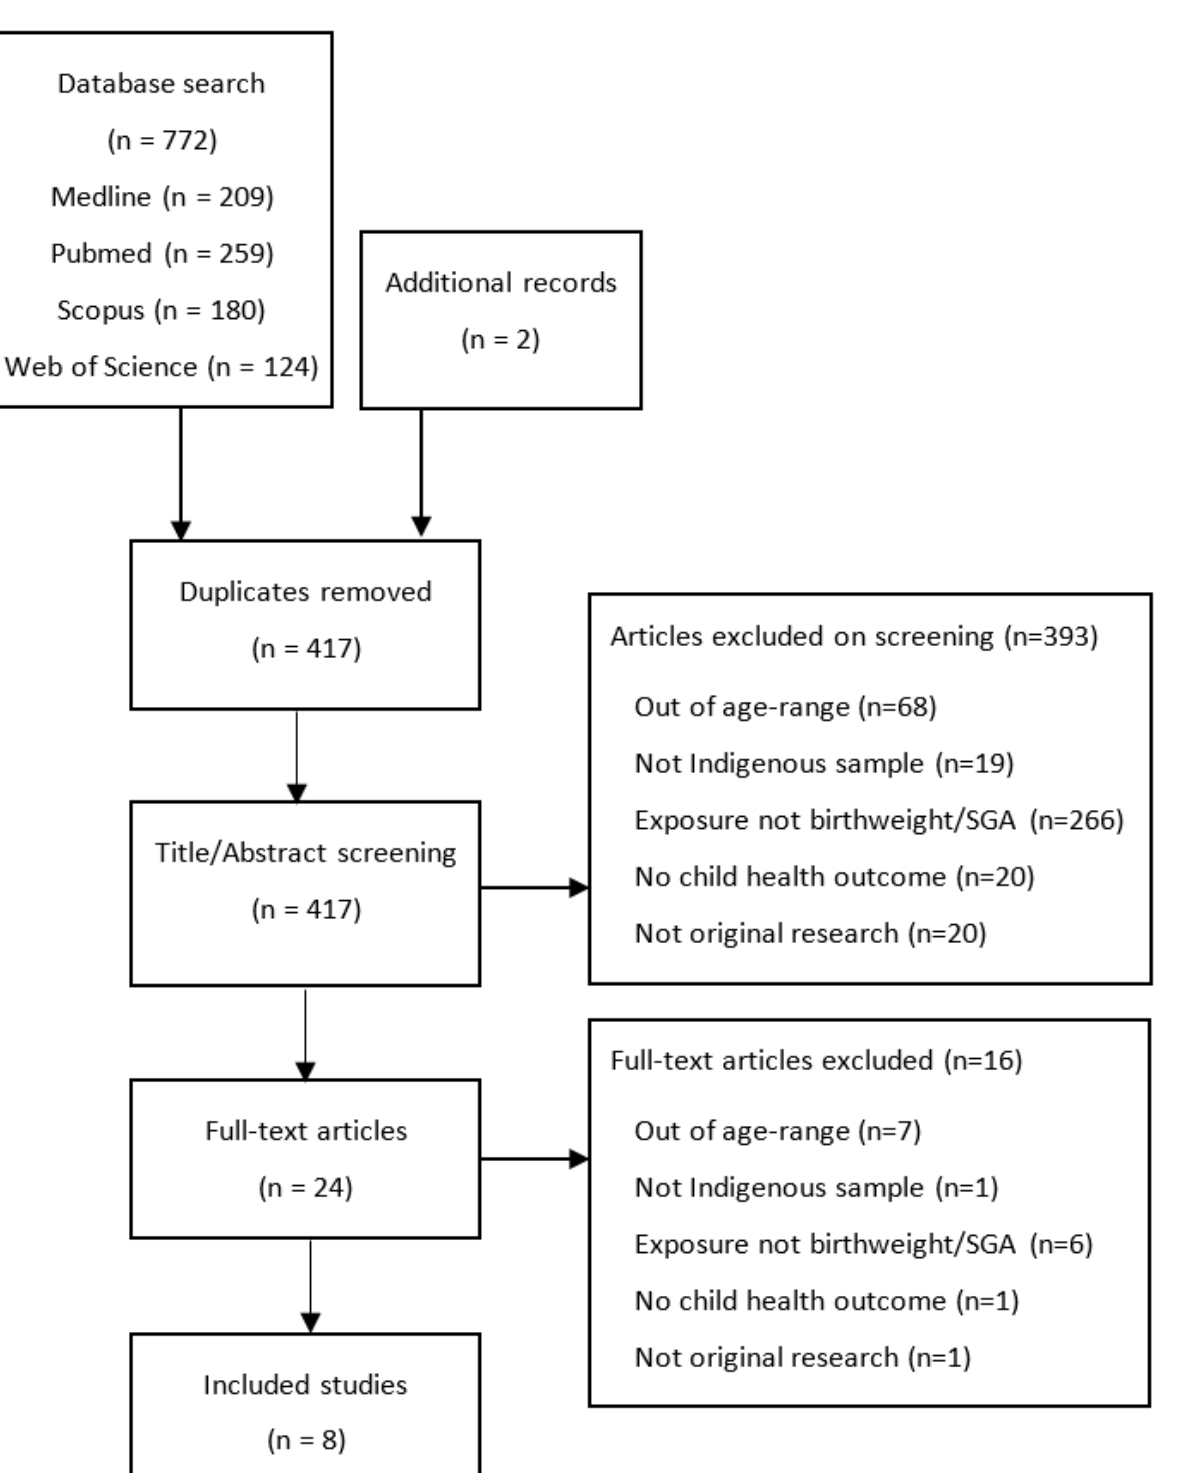
Figure 1. PRISMA Flow Diagram of study selection.